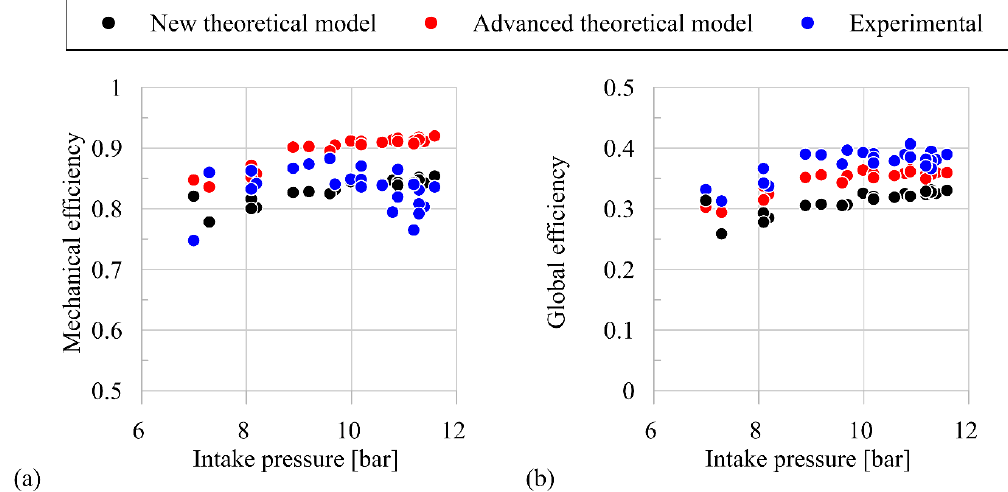
Figure 7. Comparison between experimental, new theoretical, and advanced theoretical prediction of η mech ( a ) and η glob ( b ).